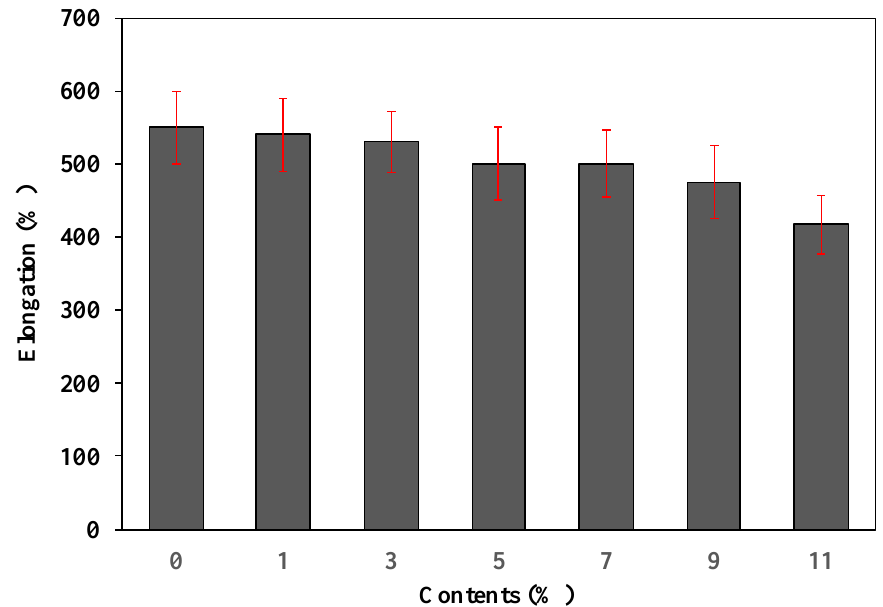
Figure 5. Elongation of polyester thermoplastic film with various contents of thermally expandable microcapsules.